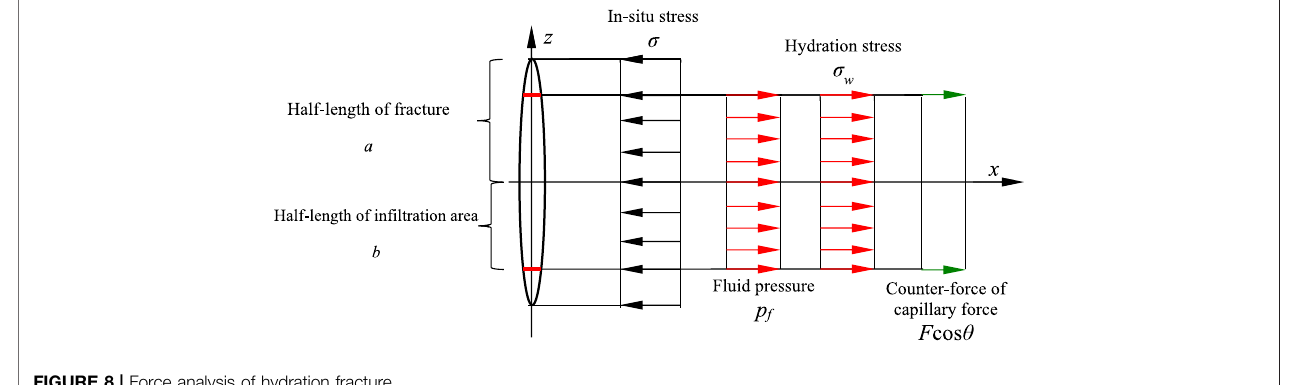
FIGURE 8 | Force analysis of hydration fracture.